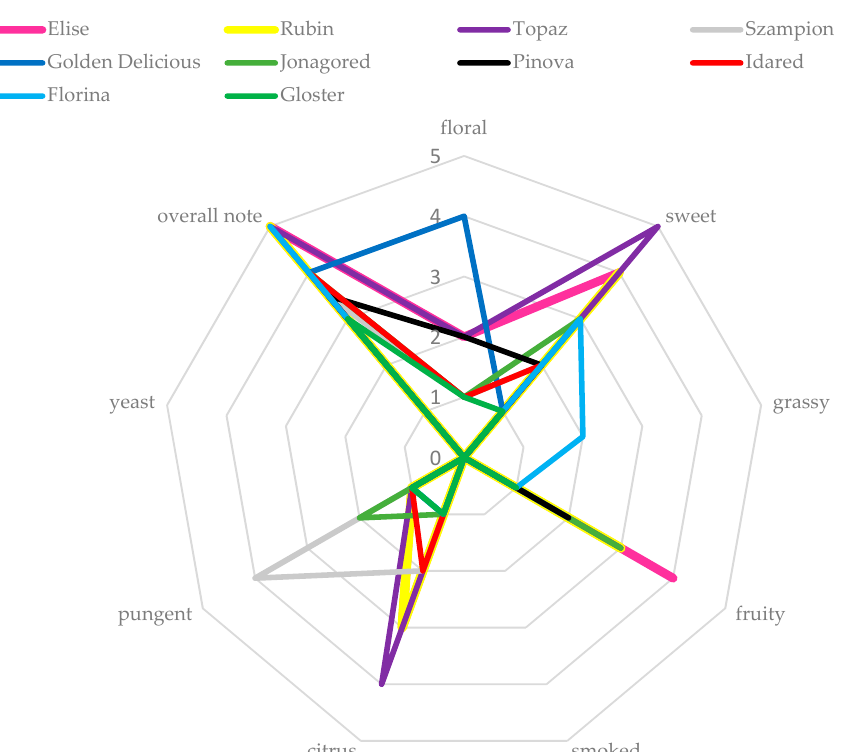
Figure 2. Characteristic aroma traits of apple spirits obtained from various apple cultivars fermented by Ethanol Red (Saccharomyces cerevisiae) yeast.